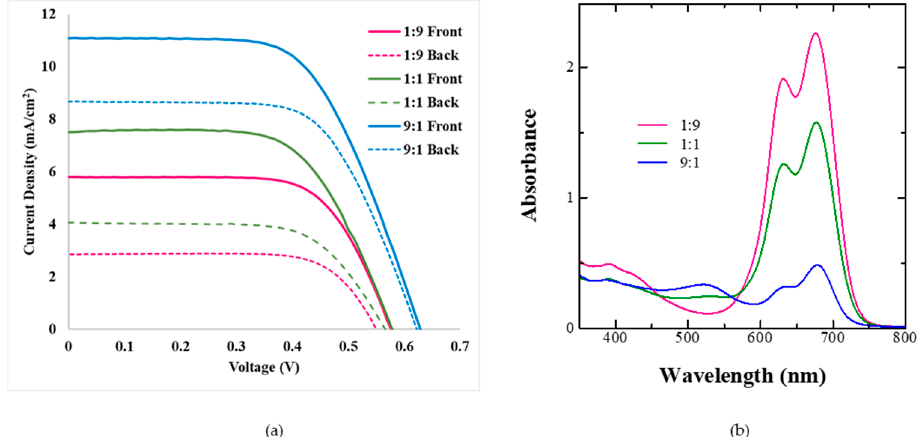
Figure 7. Photovoltaic characteristics of the BF-DSSCs based on the different dye cocktails of Z-907 and SQ-140 in different molar ratios with dye adsorption for a short period (1 h) after front and rear simulated 1 Sun irradiation ( a ) and corresponding absorption for photoanodes taken from different cocktails after 1 h of dye adsorption ( b ). Table 3. Photovoltaic parameters of BF-DSSCs using visible (Z-907) and NIR (SQ-140) dyes for a shorter time (1 h) of dye adsorption, taken in di ff erent molar ratios from their dye cocktails.